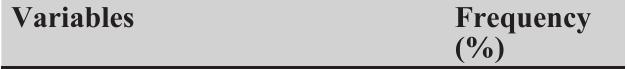
Table 1. Clinical characteristics of patients (N